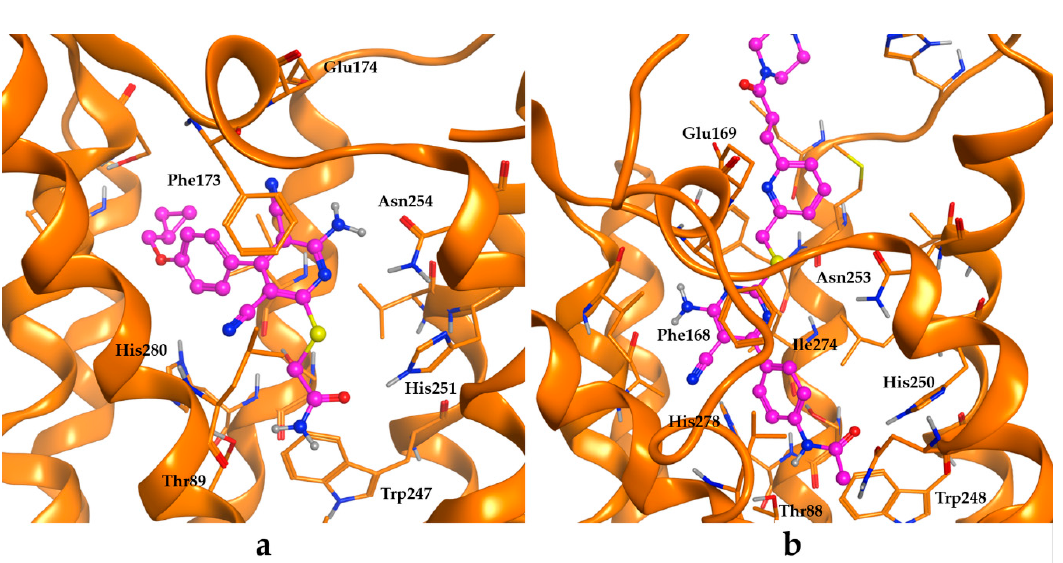
Figure 8. Putative binding mode of non-nucleoside agonists at the ARs. Panels ( a , b ) describe the potential alternative binding mode of non-nucleoside agonists at the A 2B AR (BAY 60–6583, 25 ) and at the A 2A AR ( 33 ), respectively. Key receptor residues involved in ligand–target interaction are indicated.